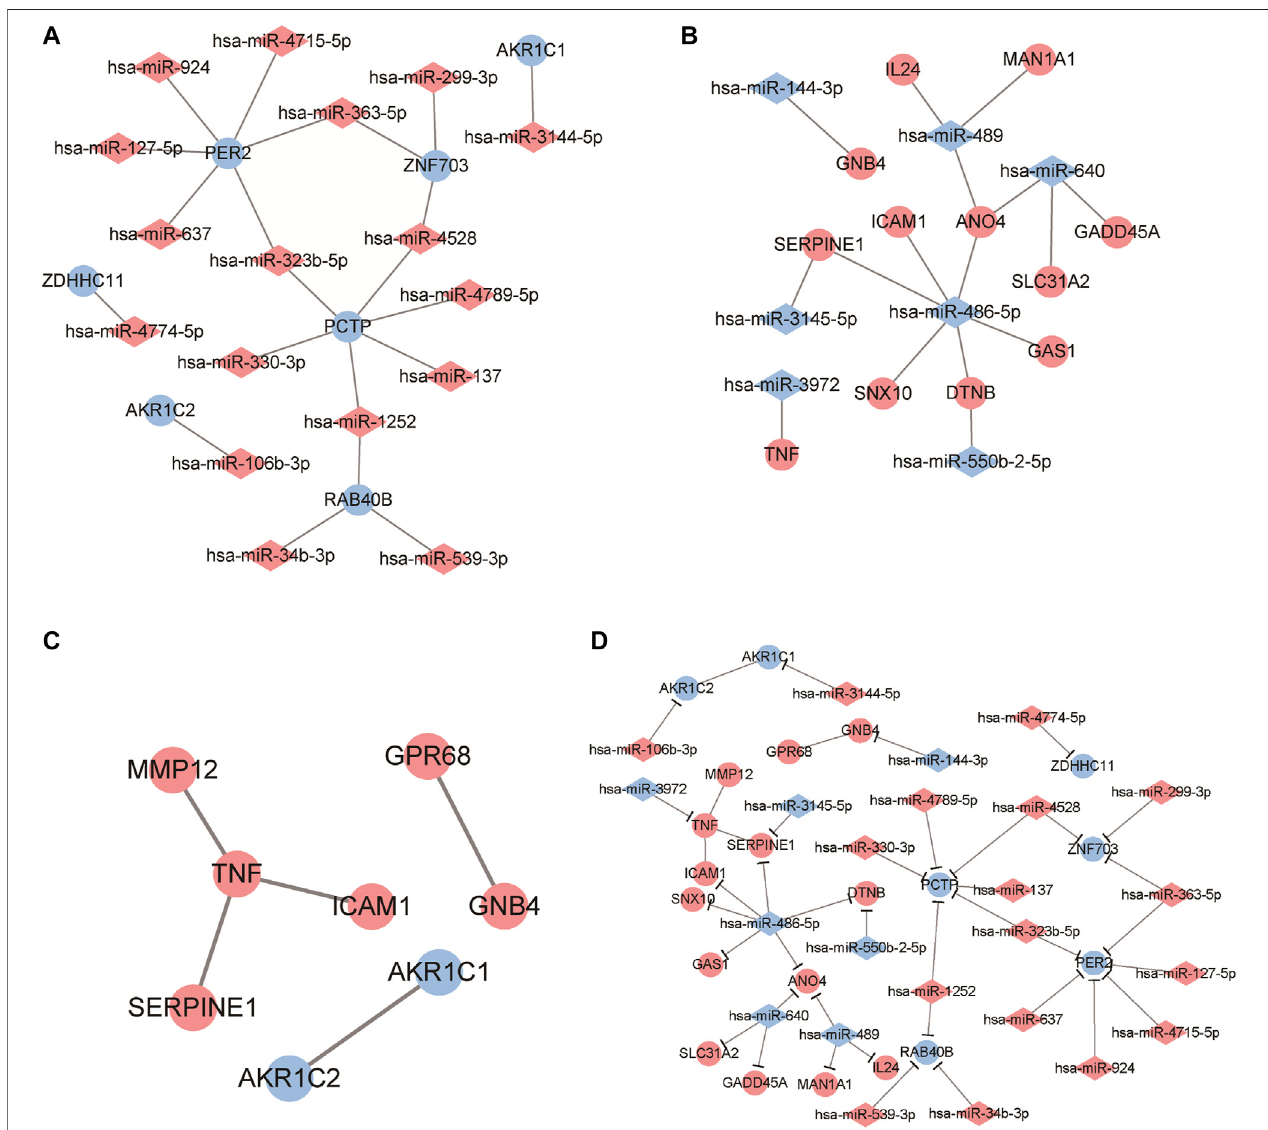
FIGURE4| Identi fi cationofcandidategenesbasedonprotein-proteininteraction(PPI)networkanalysisandmiRNA-mRNAregulatorynetworkconstruction. (A,B) Regulatory network visualized the correlation of dysregulated miRNA and mRNAs in ESCC samples. The circles represent mRNA while diamonds refer to miRNAs. Red mean to up-regulated genes and blue refer to down-regulated gene. (C) PPI network analysis for these differentially expressed genes. A red dot represents an up- regulated geneand ablue dot isadown-regulated gene. (D) ThemiRNA-mRNA regulatorynetworkanalysis toidentify crucial genesrelated toESCC progression. Red colors represent up-regulated while blue colors refer to down-regulated genes. Diamond and circles represent miRNA and mRNA.